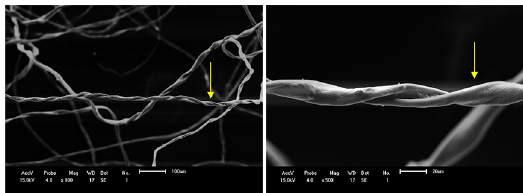
Figure 10: SEM images of Cotton linter fibrils. (Scale bar: 100 μm and 20 μm).